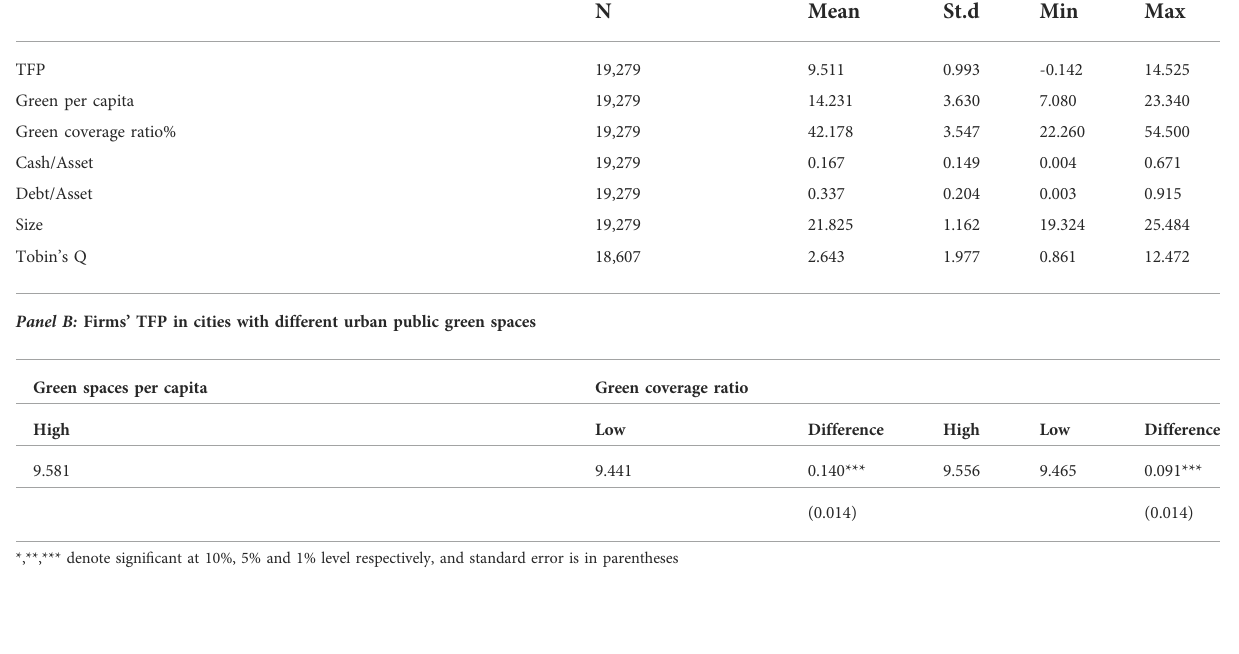
TABLE 2 The effect of green spaces on fi rms ’